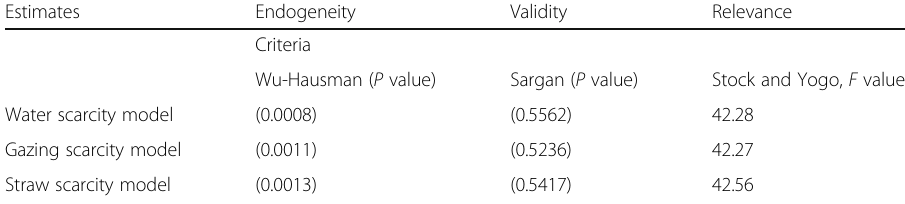
Table 2 Instrumental variables